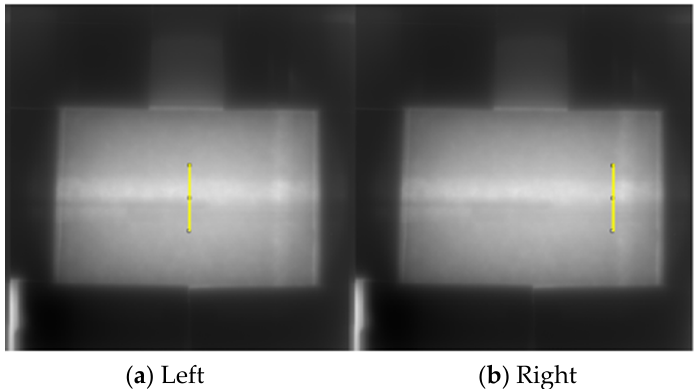
Figure 35. X-ray images of a 750 mm-thick PC bridge taken by the 3.95 MeV source. The grout is not filled. ( a ) Left; ( b ) right.